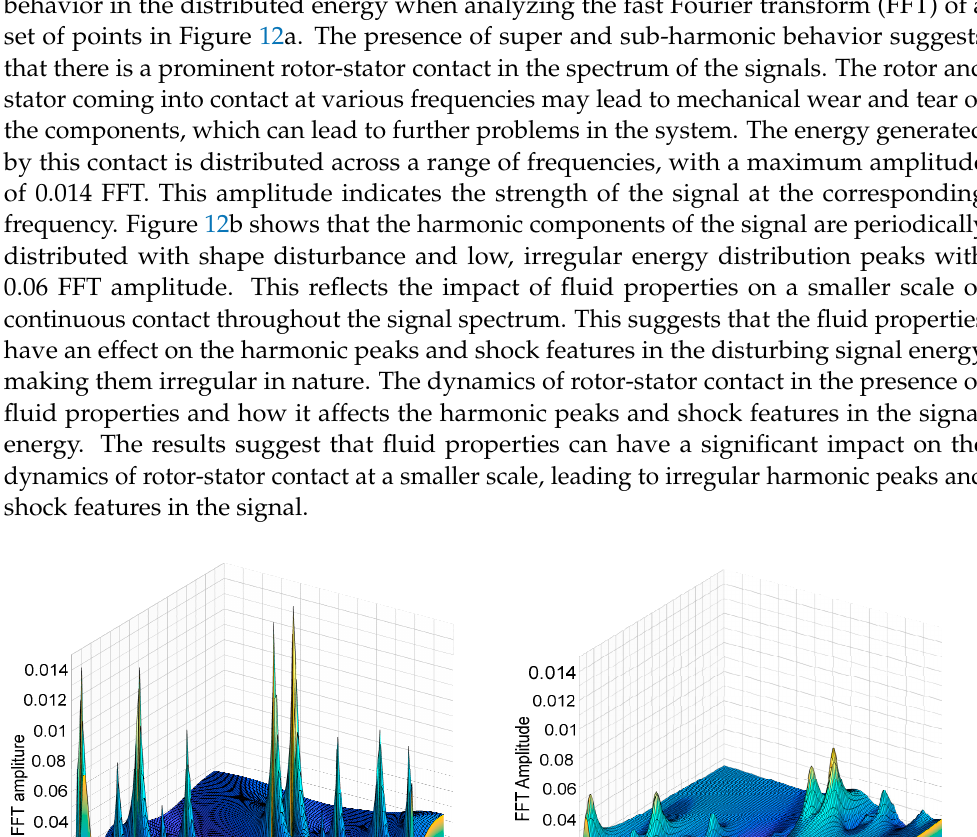
Figure 11. Time-frequency map of rotor-stator contact in fl uid; ( a ) WSST response; ( b ) IF response.